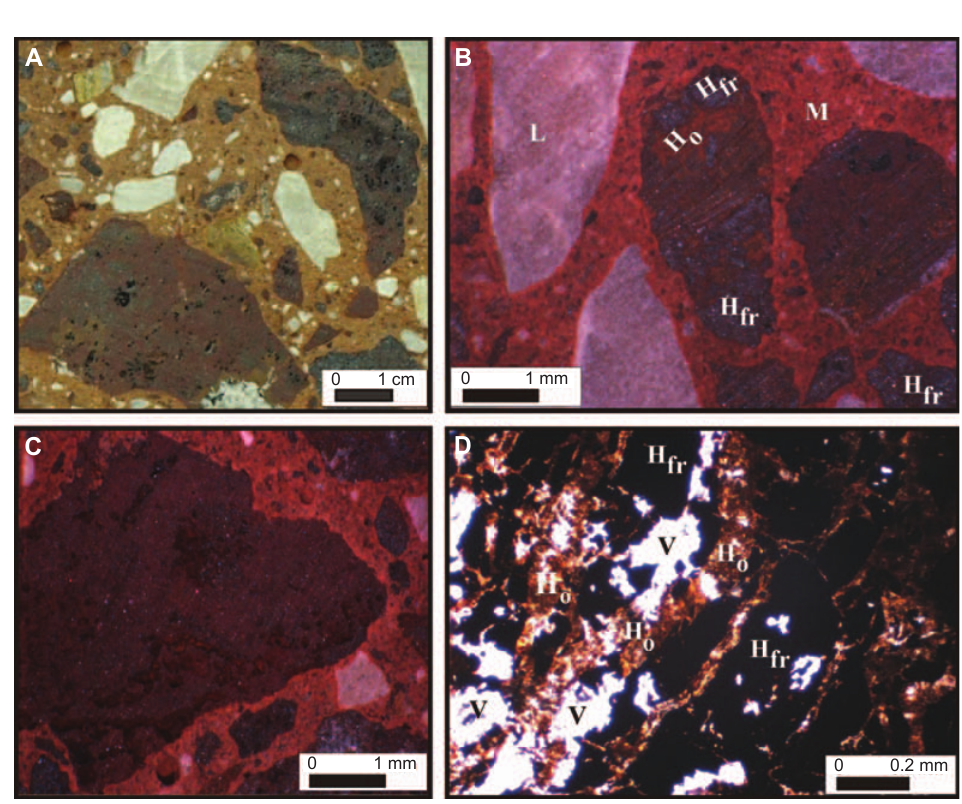
Figure 3 The microscopical view from the hematite showing its structural form.